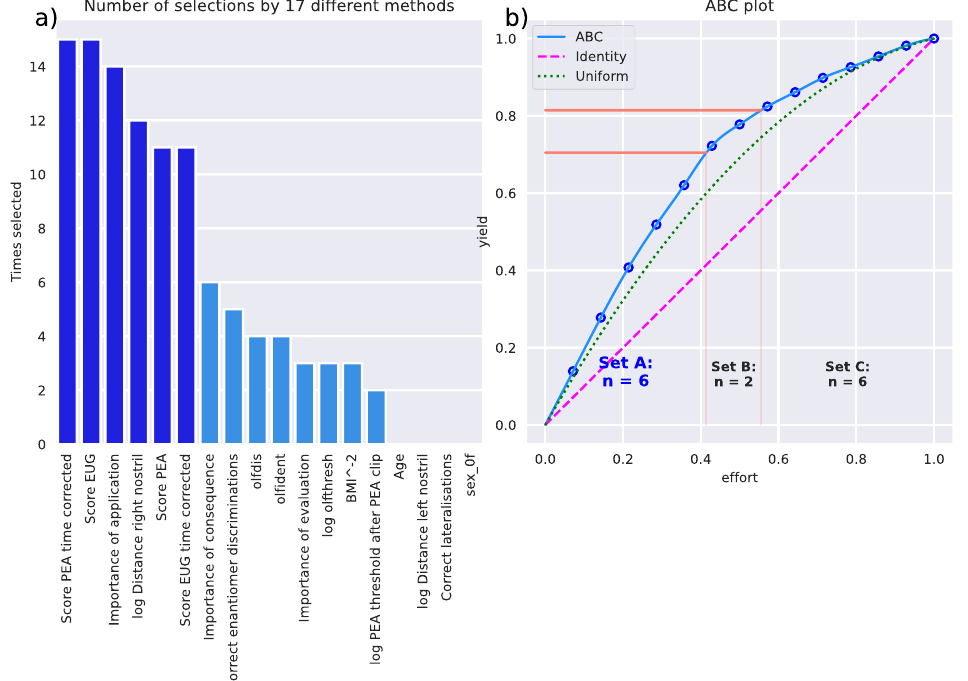
Figure 7. Identification of the variables that were most informative in assigning a subject to the k-means clusters. Feature selection by 17 different methods listed in Table 1. ( a ) The sum score of se- lections of each variable across the methods was subjected to a computed ABC analysis to identify the most informative variables for all methods of feature selection (row sums in Table 1). The darker blue bars indicate the variables selected for the reduced feature set resulting from ABC analysis-based item categorization. ( b ) ABC analysis plot (blue line) showing the cumulative dis- tribution function of the sums of occurrences in ABC category “A” in the ABC analyses previously performed with each feature selection method separately. The red lines show the boundaries be- tween the ABC subsets “A”, “B” and “C”. Category “A” with d = 6 variables is considered to in- clude the most relevant variables for cluster discrimination (marked in darker blue in panel a). The figure was created using Python version 3.8.12 for Linux (https://www.python.org, accessed on 28 January 2022), with the seaborn statistical data visualization package (https://seaborn.pydata.org,